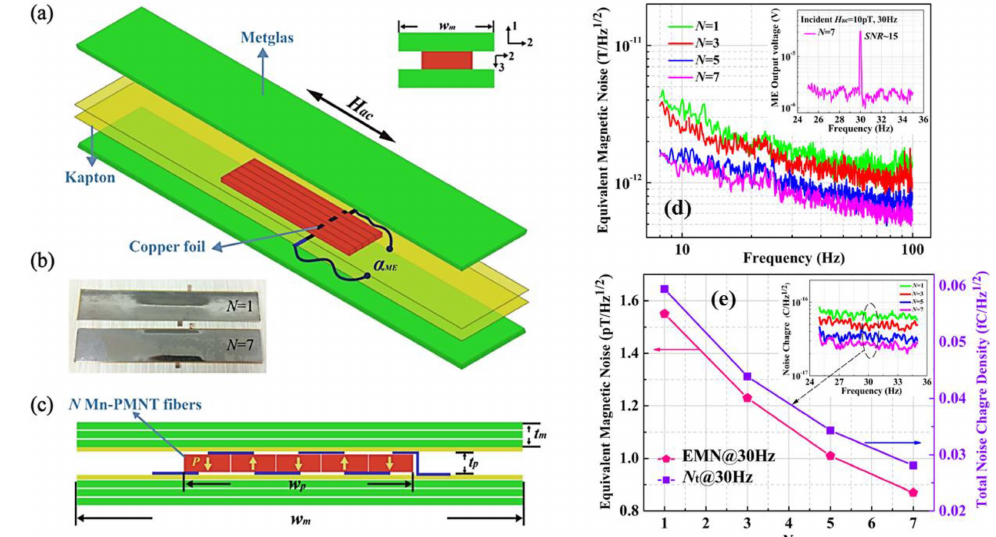
Figure 9. ( a )–( c ) 3D structure, photograph, cross-sectional schematic diagram, respectively, of the Metglas/Mn-PMNT composite. ( d ) and ( e ) Equivalent magnetic noise level and total noise charge density of the ME magnetic sensors